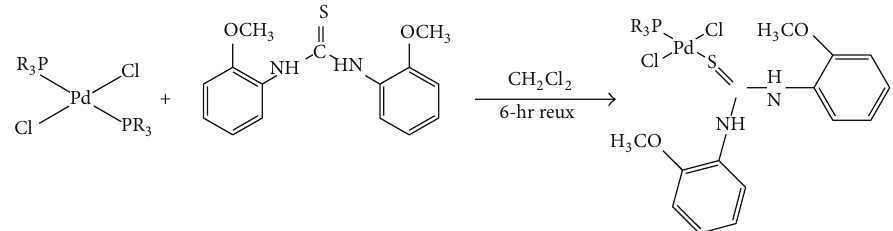
Scheme 2: Synthesis of heteroleptic Pd(II) complexes.